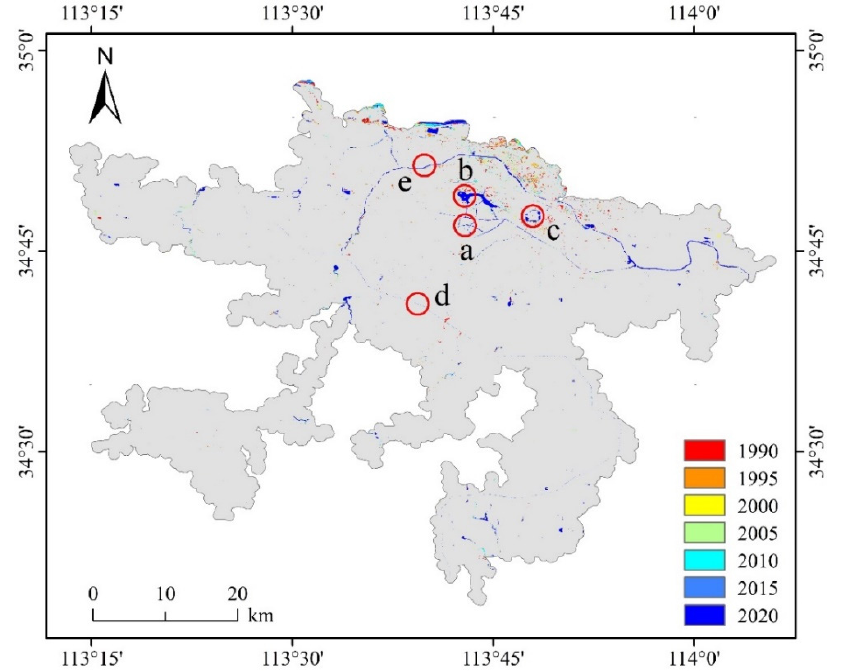
Figure 10. Spatial patterns of changes in surface water bodies in Zhengzhou City from 1990 to 2020 (a: Dongfeng River and Ruyi Lake, b: Beilong Lake, c: Longzi Lake, d: South ‐ to ‐ North Water Diversion Project transfer canal, and e: Jialu River).